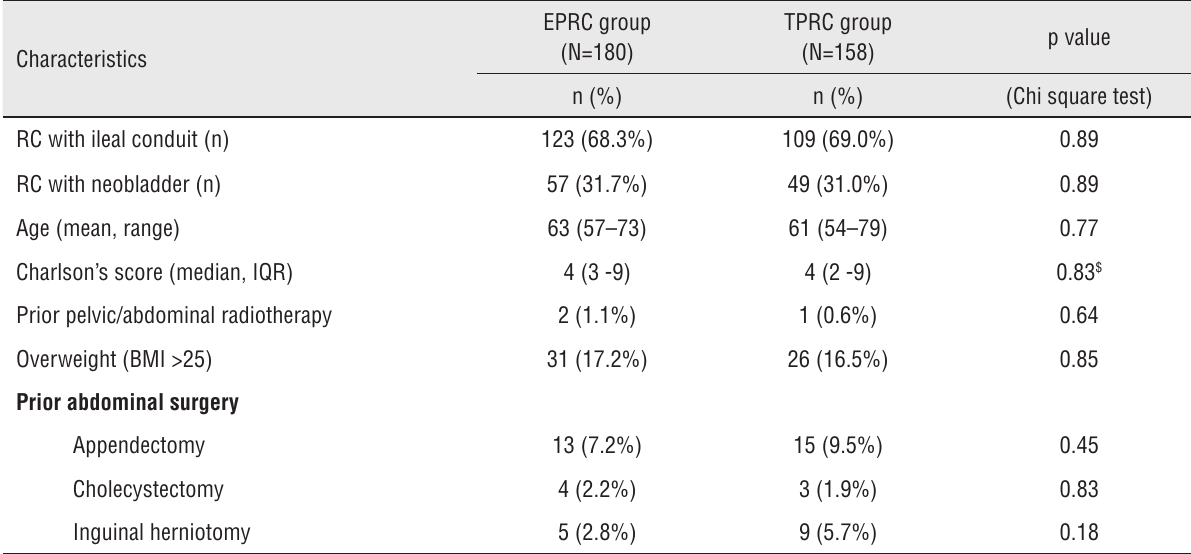
Table 1 - Patients’ clinical characteristics.